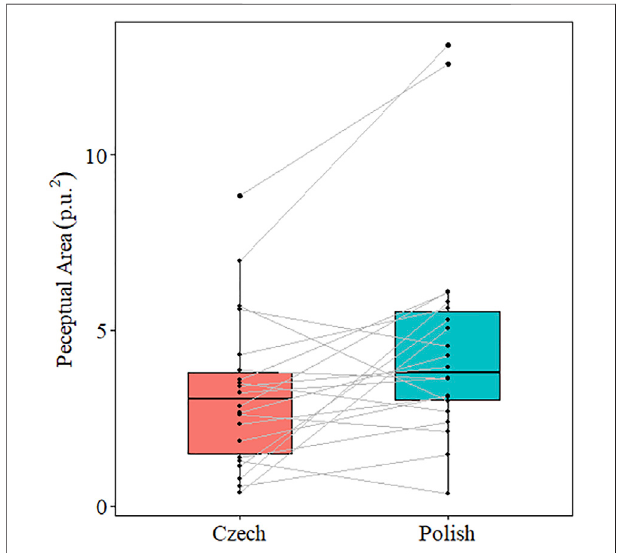
FIGURE 6 | Boxplot that presents the paired results for the perceptual space. Each of the lines connect the each of the participant ’ s Czech and Polish d-prime scores used for comparison in the statistical